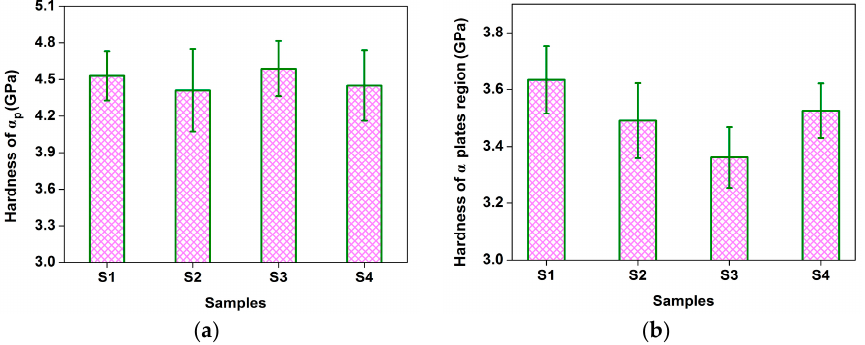
Figure 3. Hardness of different constituent phases: ( a ) α p , ( b ) α plates region.